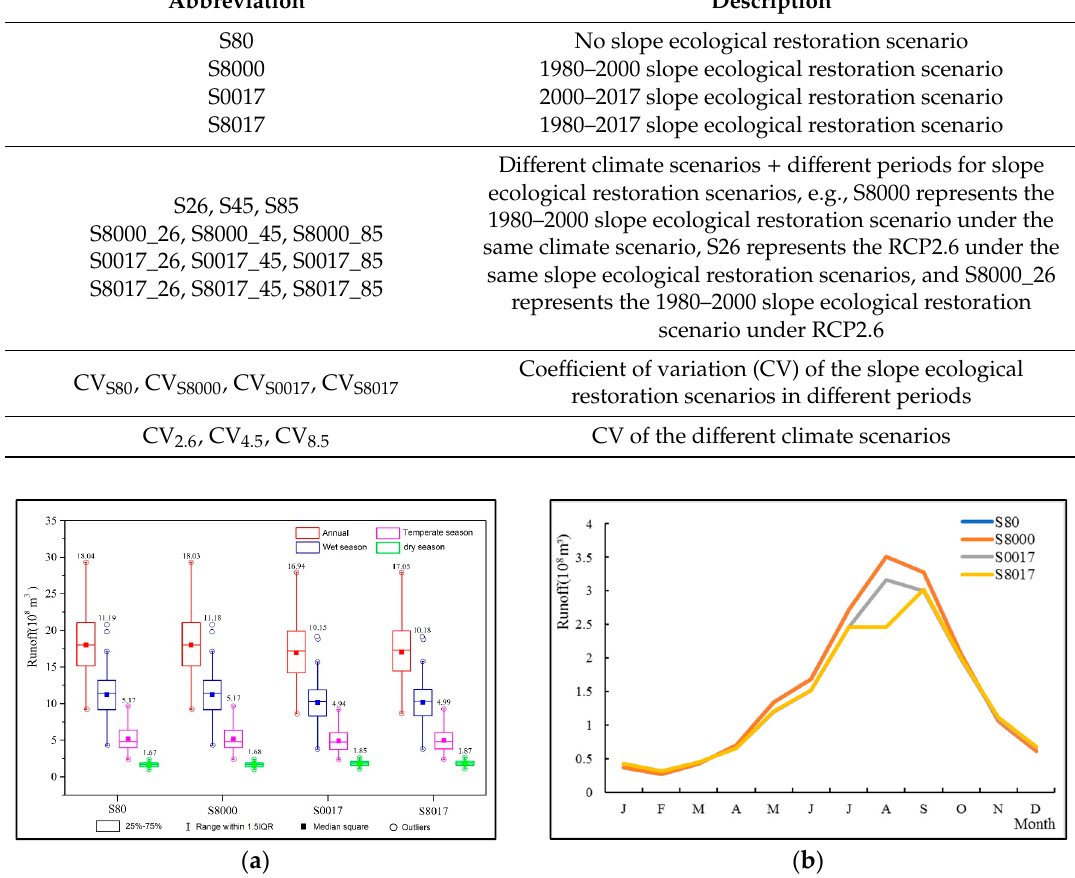
Figure 11. ( a ) Boxplots of the annual/seasonal runoff simulations for Minhe station under the four slope ecological restoration scenarios during 1965 – 2017. The number of each box represents the average. ( b ) Mean monthly runoff for Minhe station under the four slope ecological restoration scenarios during 1965 – 2017.